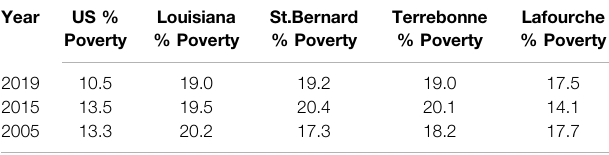
TABLE 2 | Poverty rates of study parishes and national averages in recent